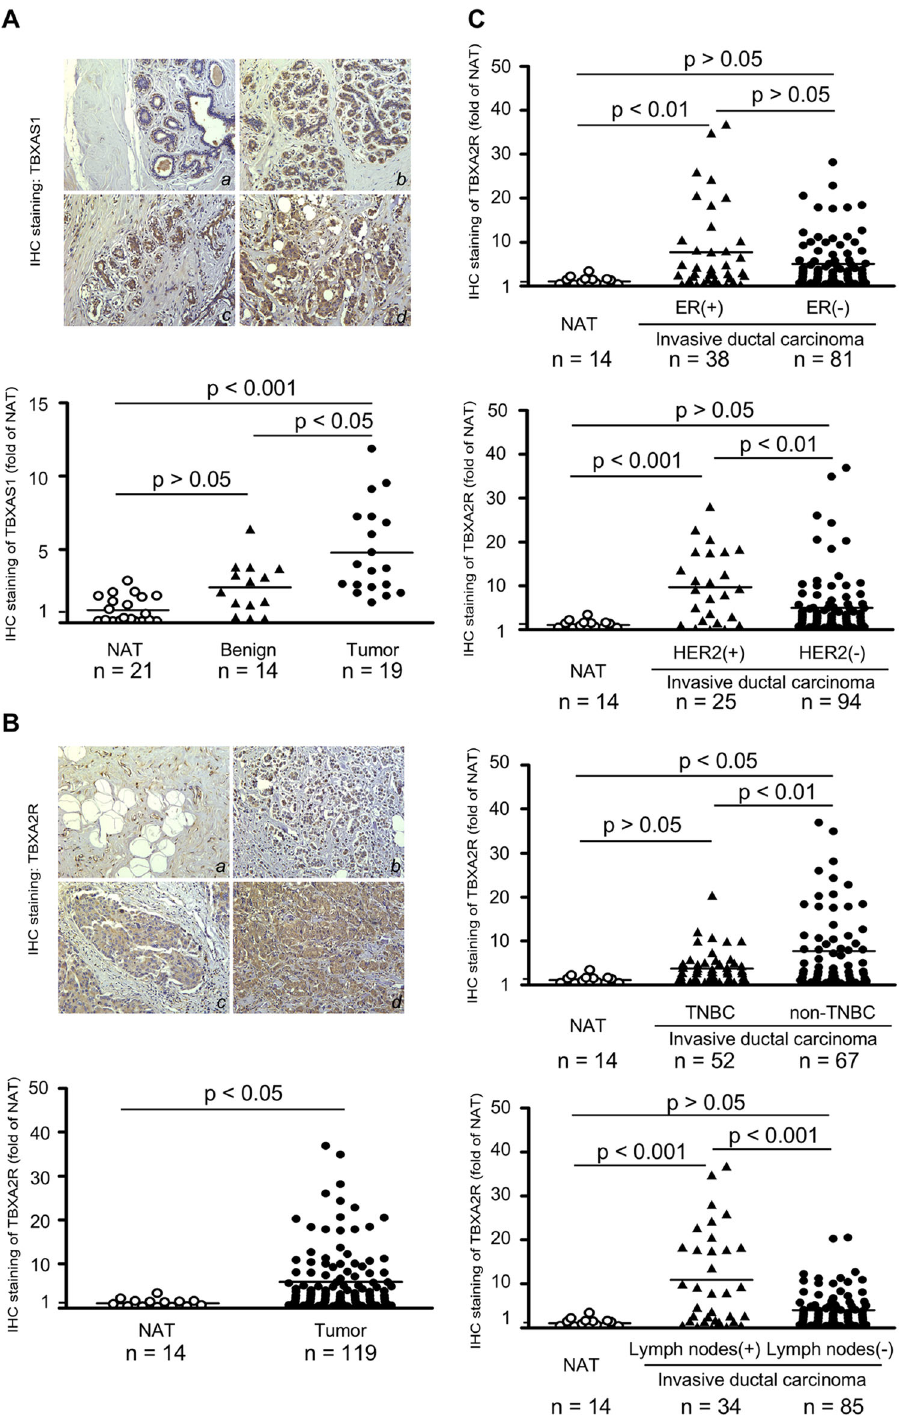
Fig. 1 Pathophysiological role of the TXA 2 pathway in human breast cancer. a Immuno-histochemical staining of TBXAS1 in human breast cancer tissues. (a) normal adjacent breast tissues; (b) adenosis of breast; (c) atypical hyperplasia of duct epithelium; (d) in fi ltrating duct carcinoma. Original magni fi cation: 200×. b Immunohistochemical staining of TBXA2R in human breast cancer. (a) normal adjacent breast tissues; (b – d) in fi ltrating duct carcinoma. Original magni fi cation: 200×. c Clinical relevance of TBXA2R in human breast cancer. For a , b , c , the graphs show the staining of TBXAS1 ( a ) or TBXA2R ( b , c ) and the horizontal line indicates the mean value. The asterisks indicate a signi fi cant difference compared with the NAT (normal adjacent tissue) group (* p < 0.05; ** p < 0.01; *** p < breast adenosis, epithelium hyperplasia and atypical ductal TBXAS1 staining in those normal-appearing mammary ductular hyperplasia. In general, the staining pattern was cytoplasmic and epithelia was often focal and of reduced in intensity relative to granular. Within the same tissue sections, TBXAS1 staining was neoplastic epithelia. Because TXA 2 is known to function through localized mainly in tumor cells instead of stromal cells. the activation of the thromboxane A 2 receptor (TBXA2R), we